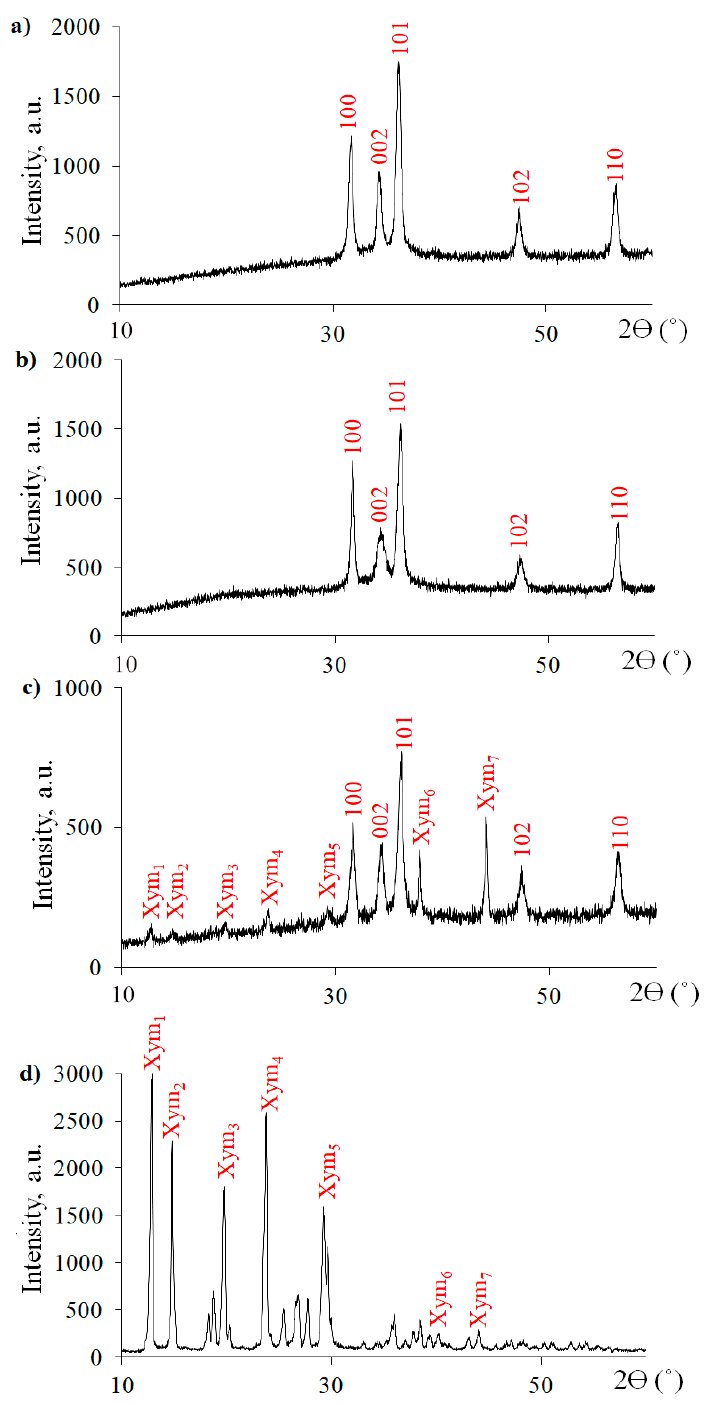
Figure 3. Powder XRD patterns of ZnO NPs ( a ), ZnO NPs–PEG ( b ), ZnO NPs–Xym ( c ), and xymedone ( d ).